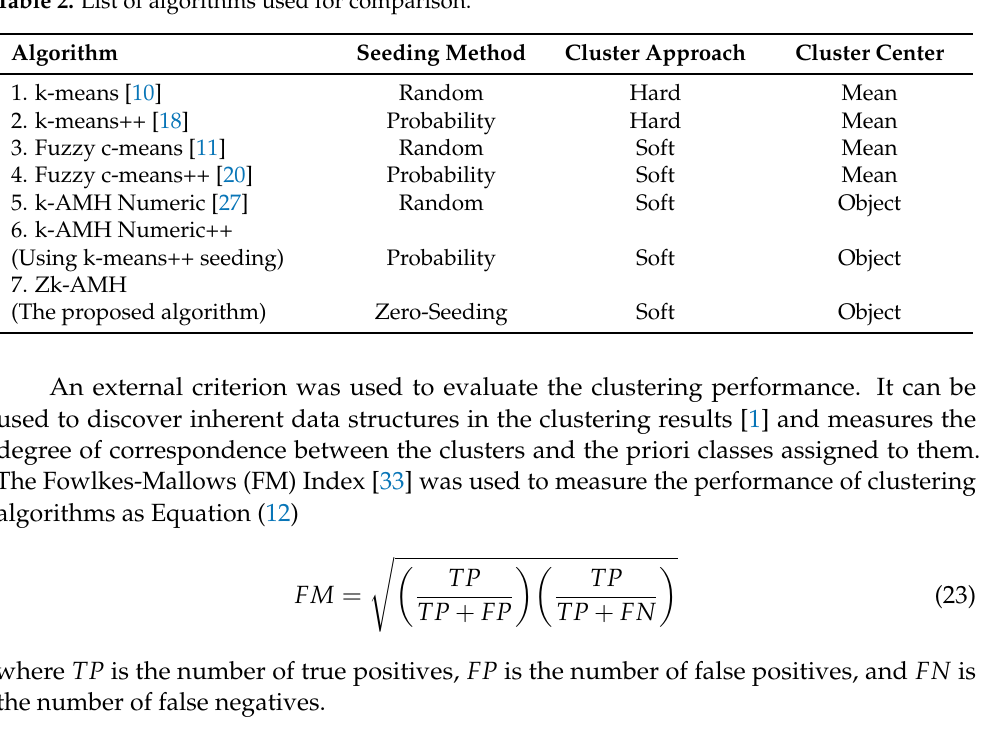
Table 2. List of algorithms used for